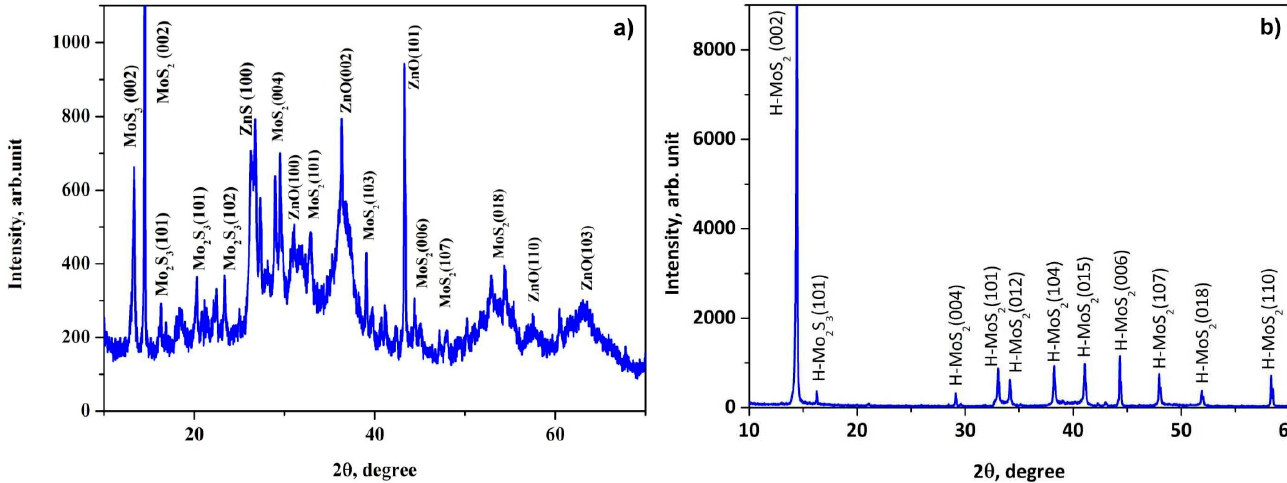
Figure 2. X-ray diffraction (XRD) patterns of the prepared MoS 2 @ZnO nanoheterostructures ( a ) and initial nanostructured MoS 2 ( b